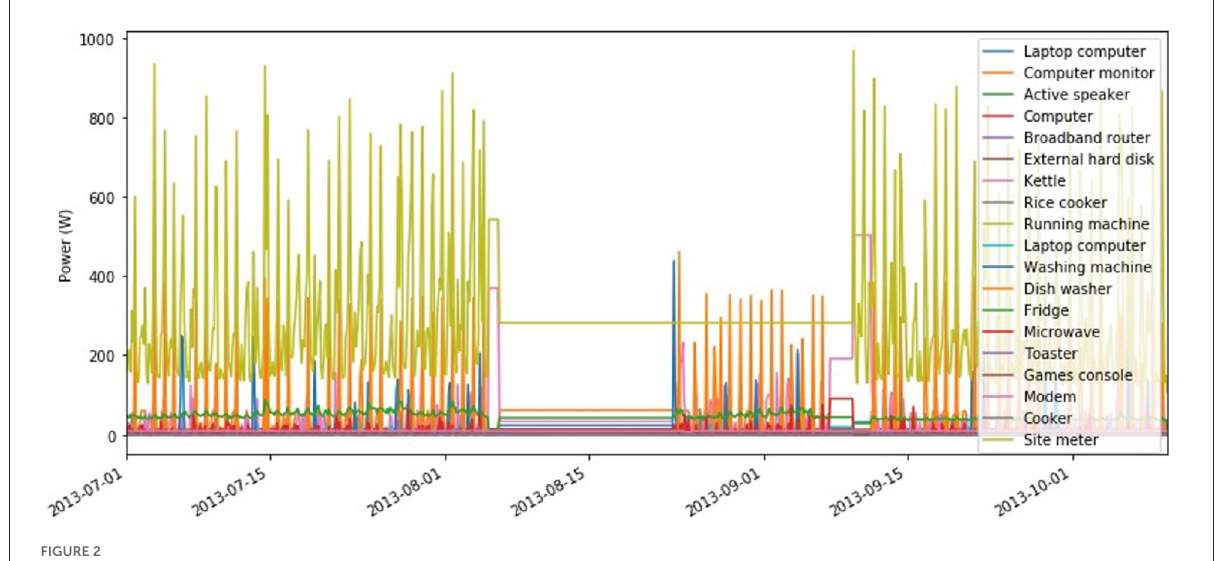
FIGURE2 House 2 appliance’s and mains power